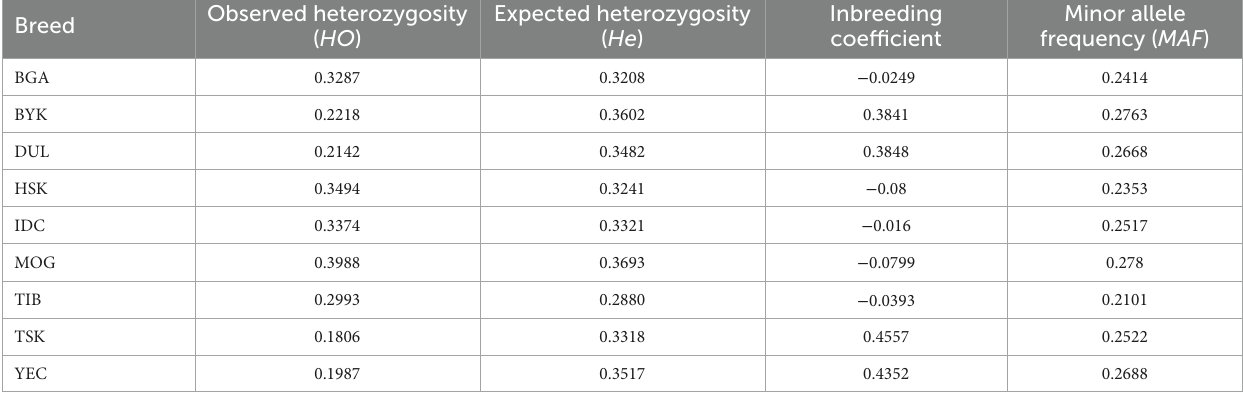
TABLE 2 The observed heterozygosity ( H